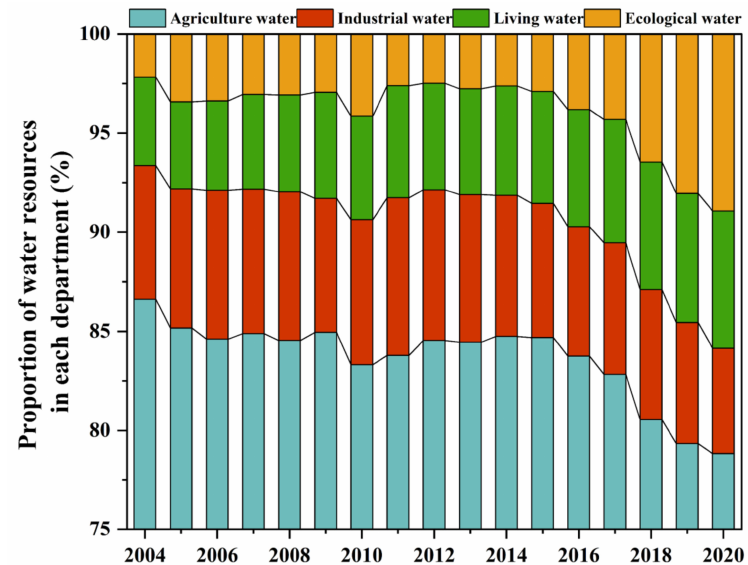
Figure 3. The characteristics of water consumption in various departments over time.